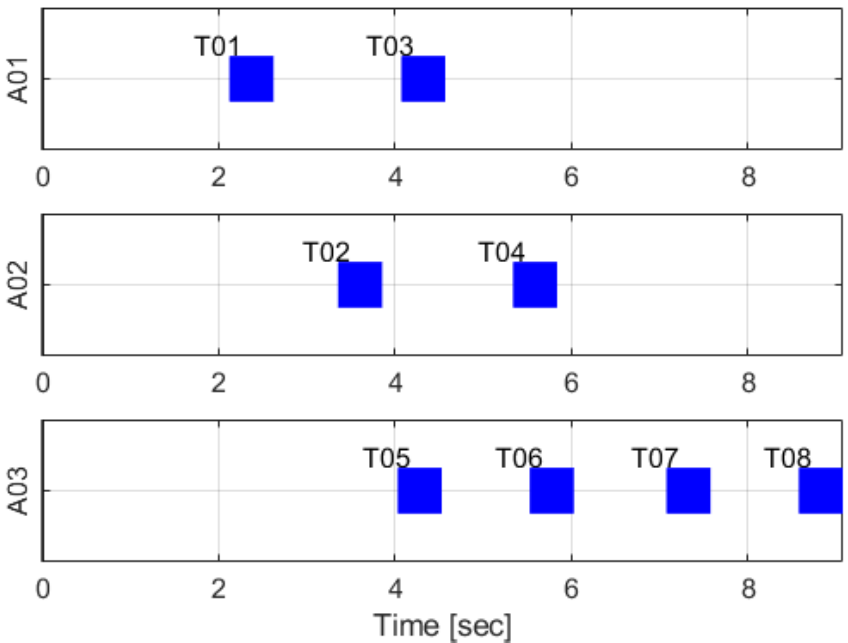
Figure 3. Timetable result of TACTAR for a simple case applying a modified time-discounted reward scheme.